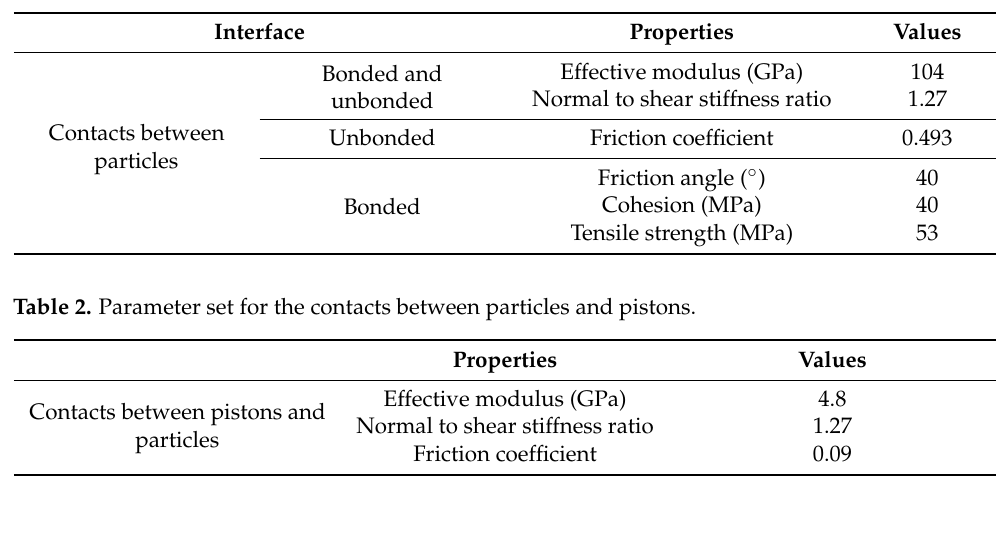
Table 1. Parameter set for the linear parallel bond model with constant values.